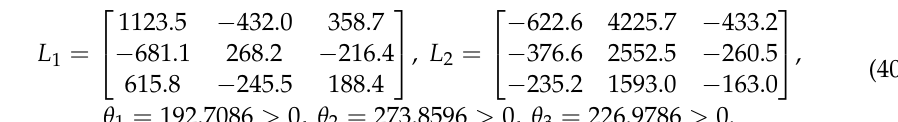
According to Figure 10 and SFC case, take ϕ = 0.5 and ψ = 2.6 to solve (31) and (32) in Theorem 5; then, we obtain